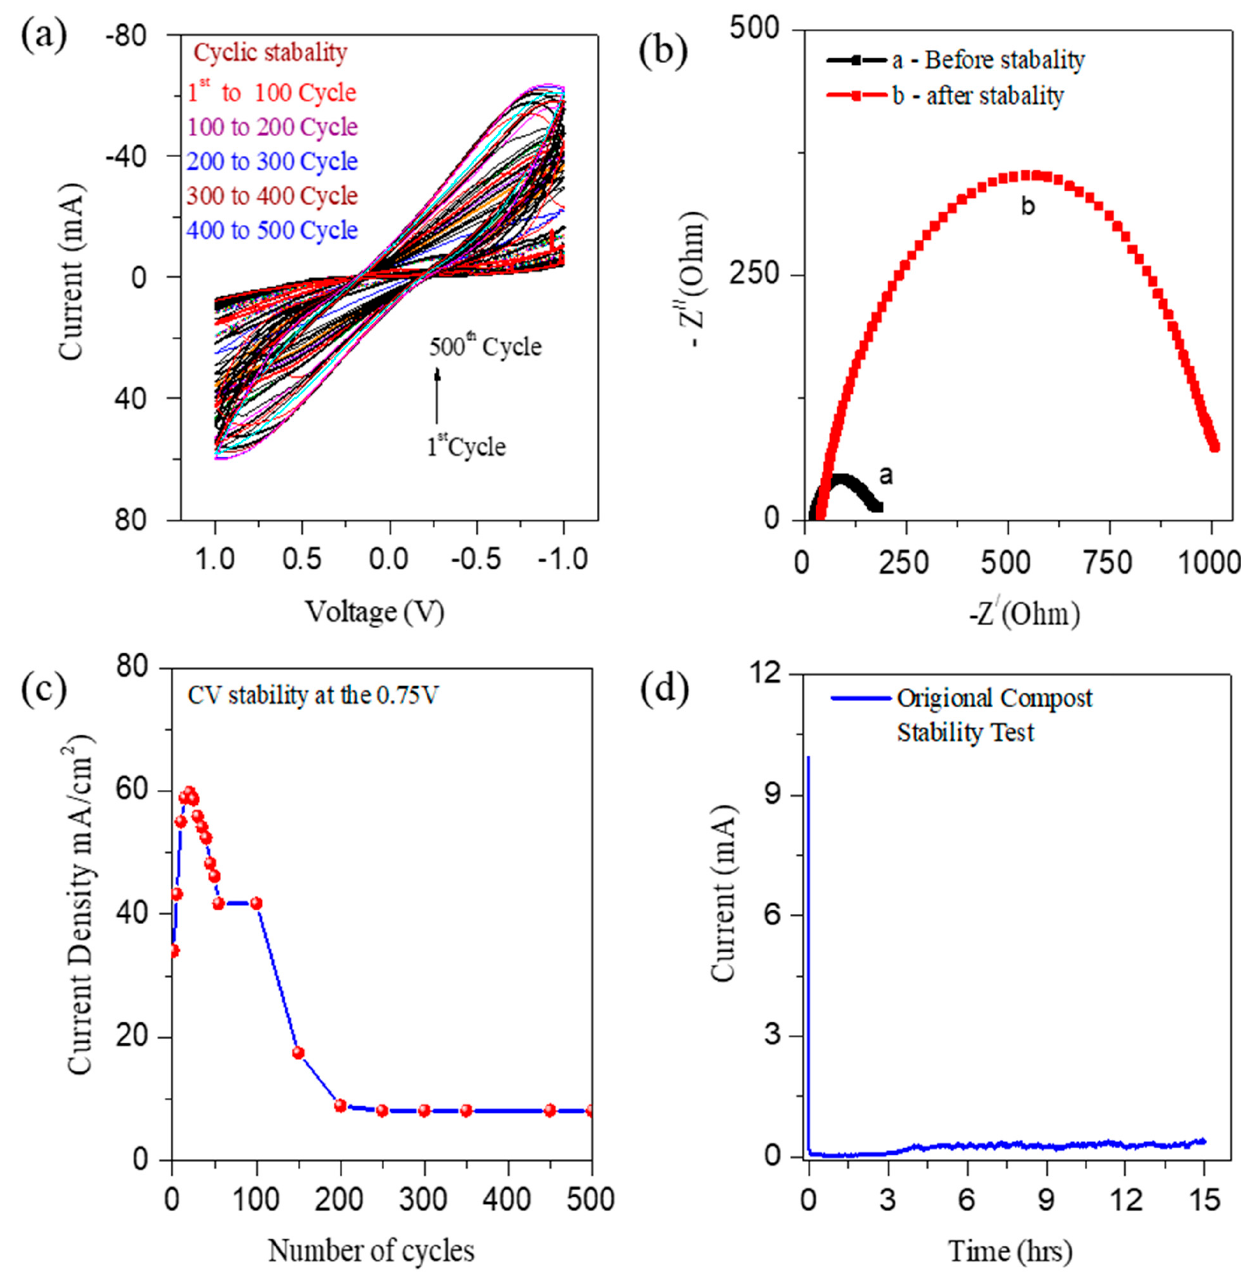
Figure 4. Electrochemical cyclic stability measurements of CS-AFCs with ferricyanide and a single shot of fuel (0.2 g/mL). (a) Cyclic stability recorded for 500 cycles. ( b ) EIS study before and after the stability of 500 cycles; ( c ) current density vs. cycle number. ( d ) Chronoamperometry stability for 12 h.